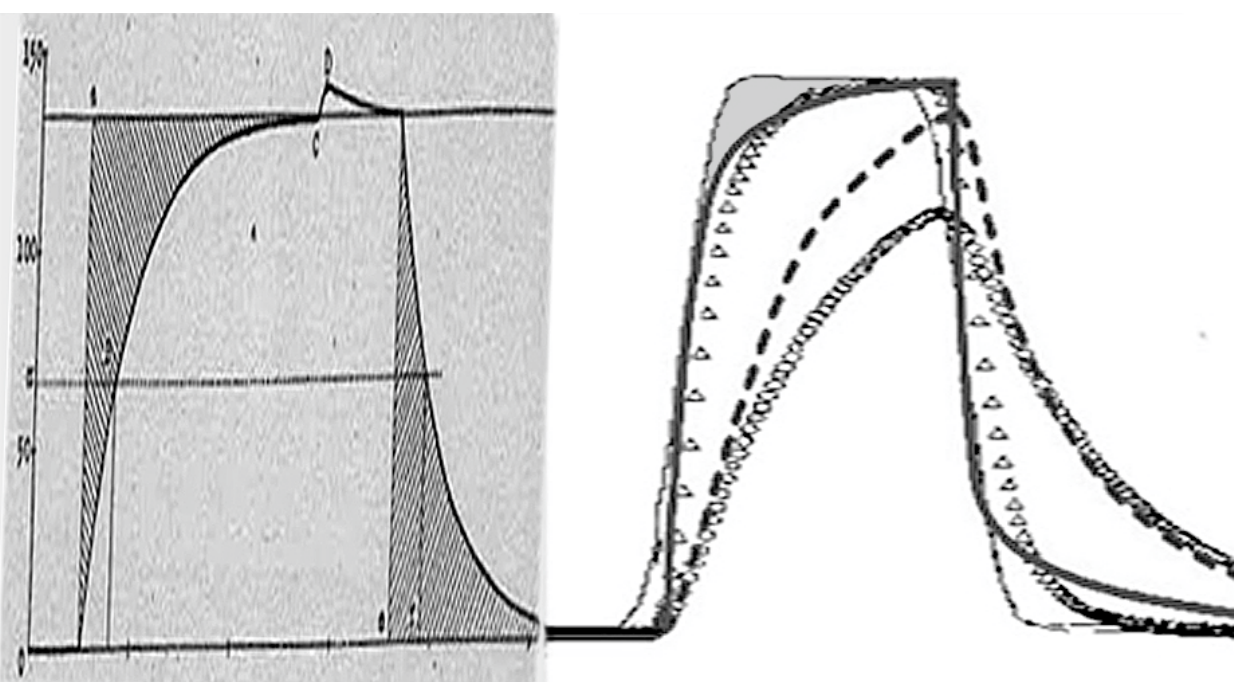
Figure 2. Historical replica of a calibrating pulse of heat transferred from Tian’s 1933 publication compared with rectangular heat pulse artificially inserted recently into the sample by either method: electrically by resistant heating inside the sample carried out under steady heating and (j) external heat irradiation onto the sample surface during the isothermal regime. Both pulses are normalized on the < ∆ T vs. t> axis as to fine-tuning the same shape regarding the inserted rectangular pulse (thin solid). The as-measured DTA response peak (dashed line, resistant heating) was mathematically corrected on the heat inertia effect by the differential method to yield the rectified peak (full line) [11,48]. The as-measured DTA feedback on the externally applied heat-pulse (small-circle line) was corrected by the standard Netzsch instrumental software [49] based on integral method providing a rectified peak (small-triangles line). Both rectifications encompass the same character of the necessary adjustment showing the necessity of corrections for kinetic interpretations due to radical changes in the ratio of partial areas used to determine the degree of conversion. It is clear that the effect of thermal inertia is non-linear (s-shaped) and therefore cannot be compensated [12,14] for a kinetic analysis of a singular peak by a single multiple coefficient often known as calorimetric constant, τ , derived from the fading part of a thermal record [46]. Shaded area of rectangular misfit on the right curves associates to unenclosed effects of temperature gradients in the sample body.